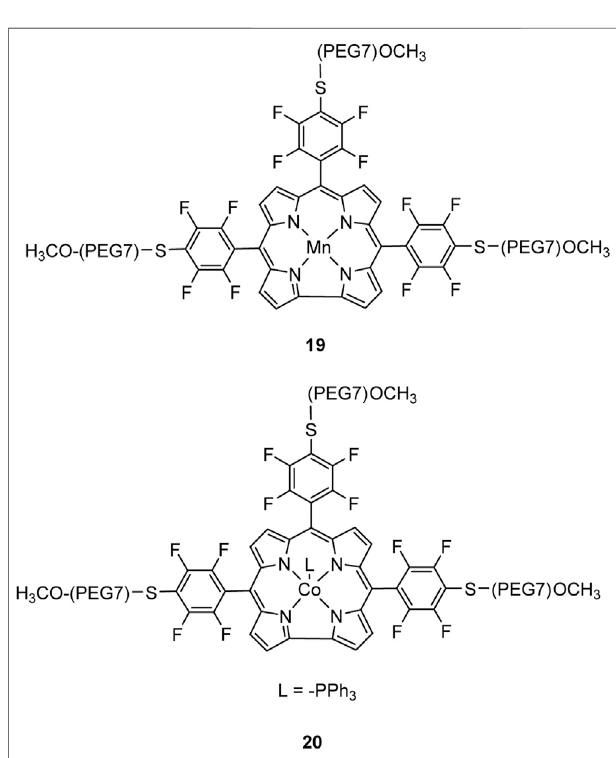
FIGURE 7 | Co − and Mn-corrole complexes reported by Roy and Schöfberger et al. (Gonglach et al., 2019).